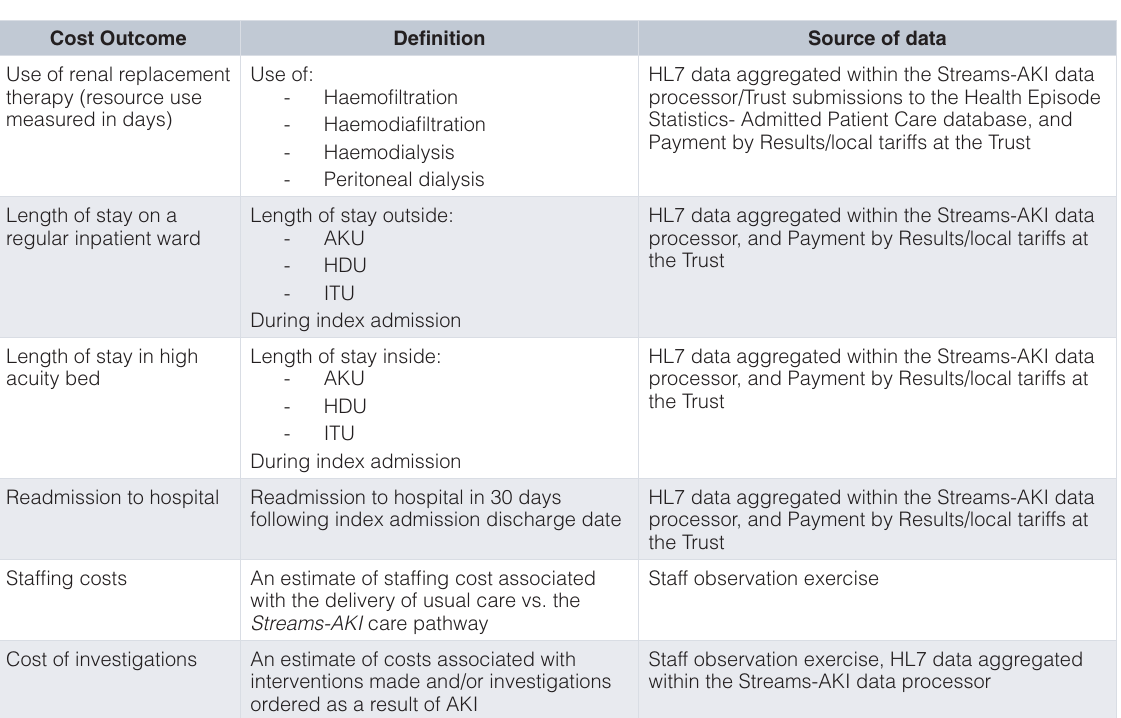
Table 4. Definitions and data sources for NHS cost outcome measures.